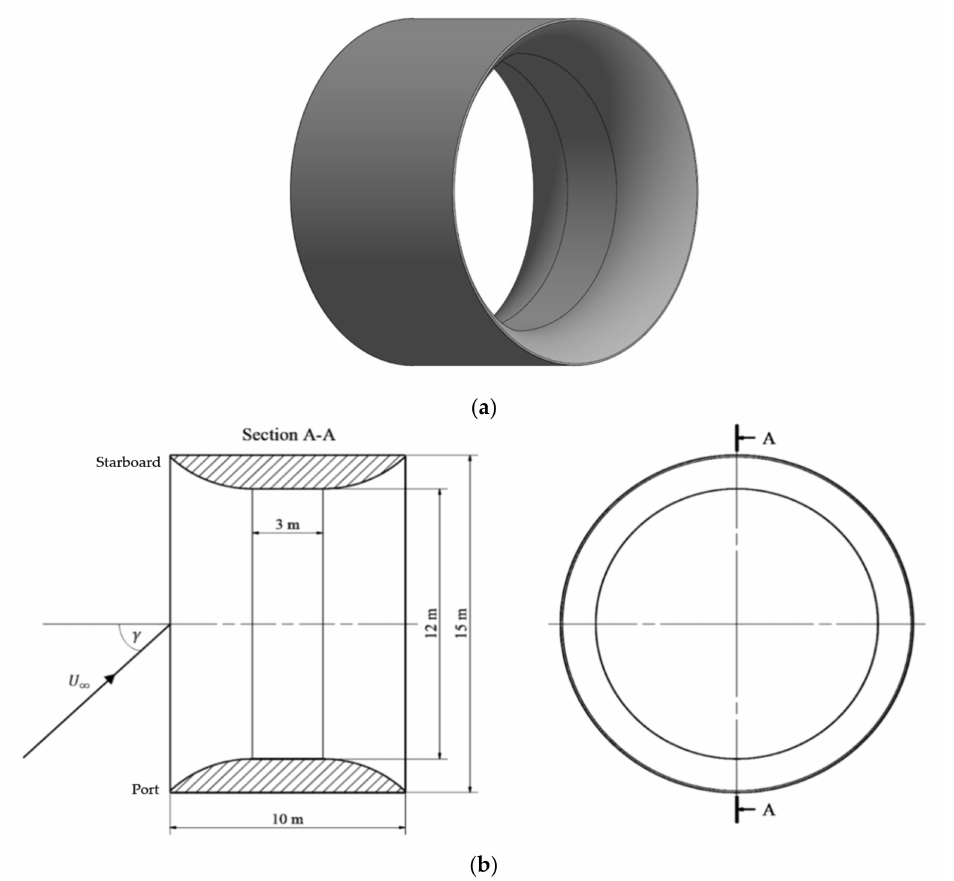
Figure 3. Geometric representation of the duct. ( a ) Rendered three-dimensional CAD representation; ( b ) First-angle sectioned